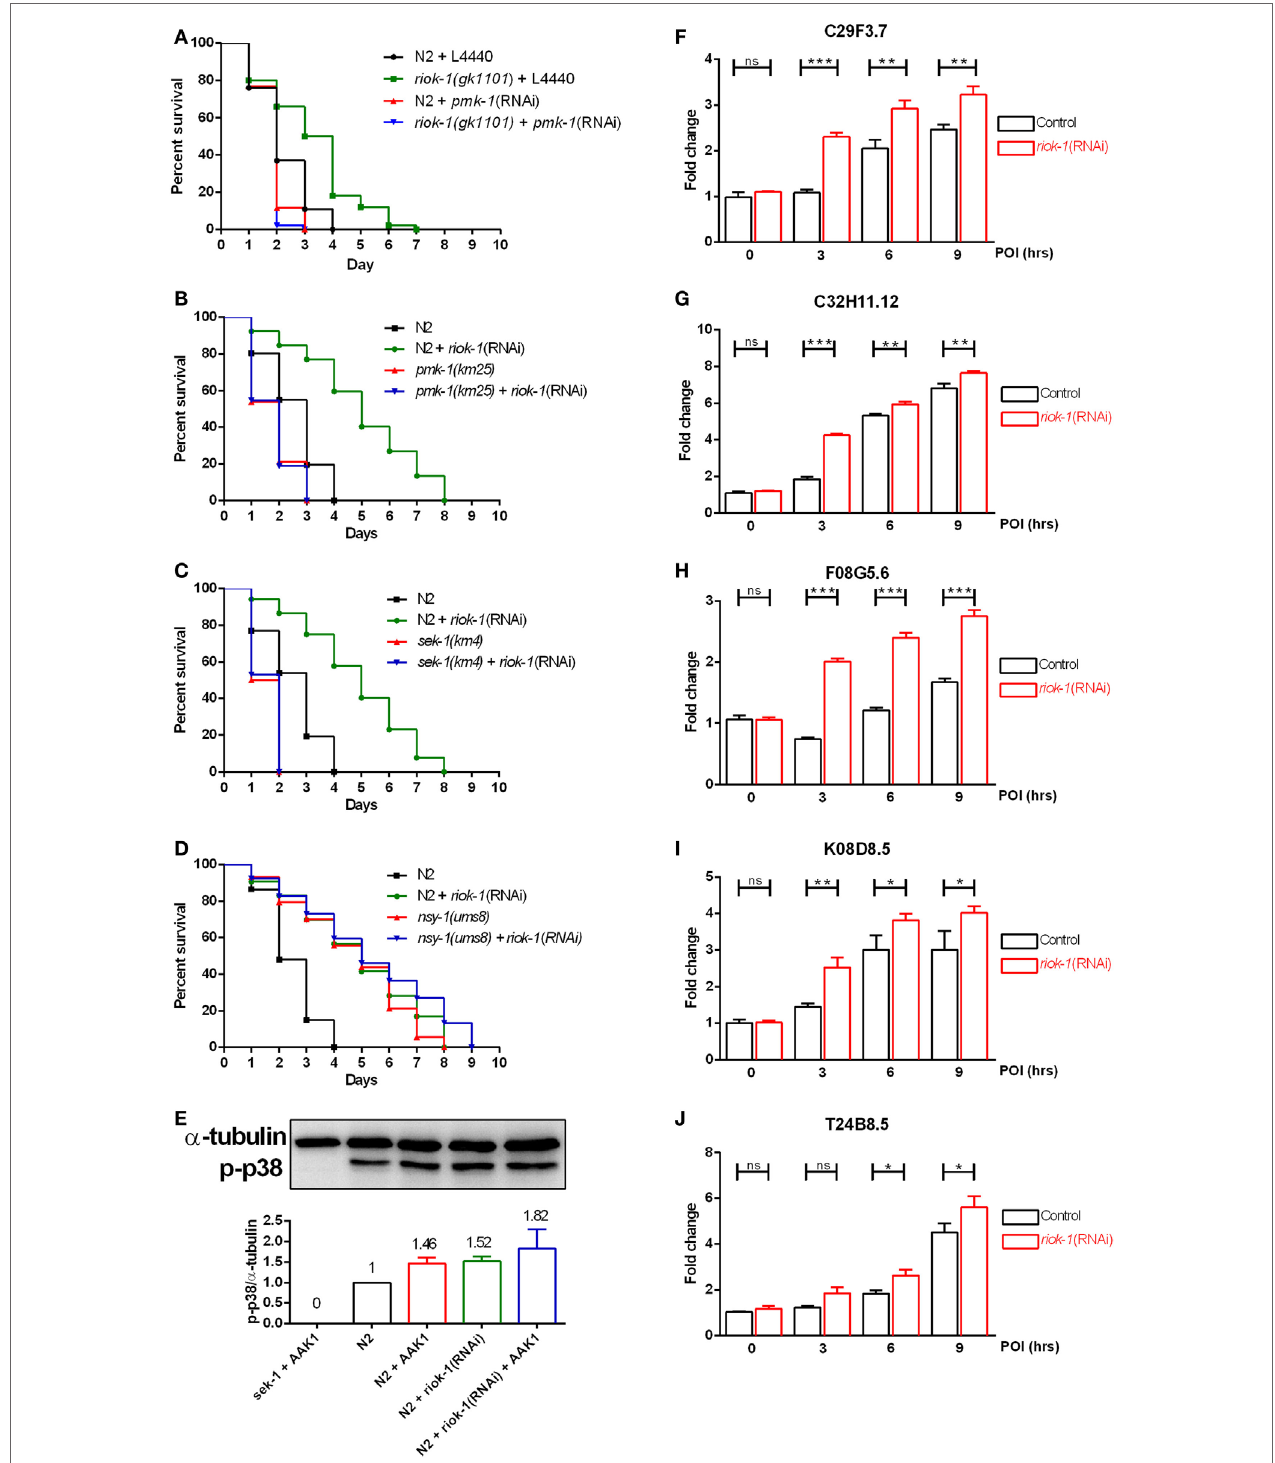
FigUre 4 | riok-1 negatively regulates the p38 MAPK pathway. (a) Life spans of wild-type N2 and riok- 1( gk1101 ) worm knockdown with pmk-1 RNAi were both shortened. (B) MAPK ( pmk-1 ) mutants, (c) MAPKK ( sek-1 ) mutants, and (D) MAPKKK ( nsy-1 ) gain-of-function mutants with riok-1 knockdown using RNAi showed similar life spans when compared with those without RNAi knockdown under A. dhakensis infection. (e) A. dhakensis infection and RNAi-mediated riok-1 knockdown induced p38 phosphorylation as shown in a Western blot analysis. (F–J) Increasing expression of p38 MAPK downstream genes C29F3.7 (F) , C32H11.12 (g) , F08G5.6 (h) , K08D8.5 (i) , and T24B8.5 (J) as determined using qRT-PCR in worms with riok-1 knockdown mediated by RNAi under A. dhakensis infection. For the unprocessed data of western blot analysis in (e) , please see the Figure S6 in Supplementary Material. *** P < 0.001, ** P < 0.01, and * P <